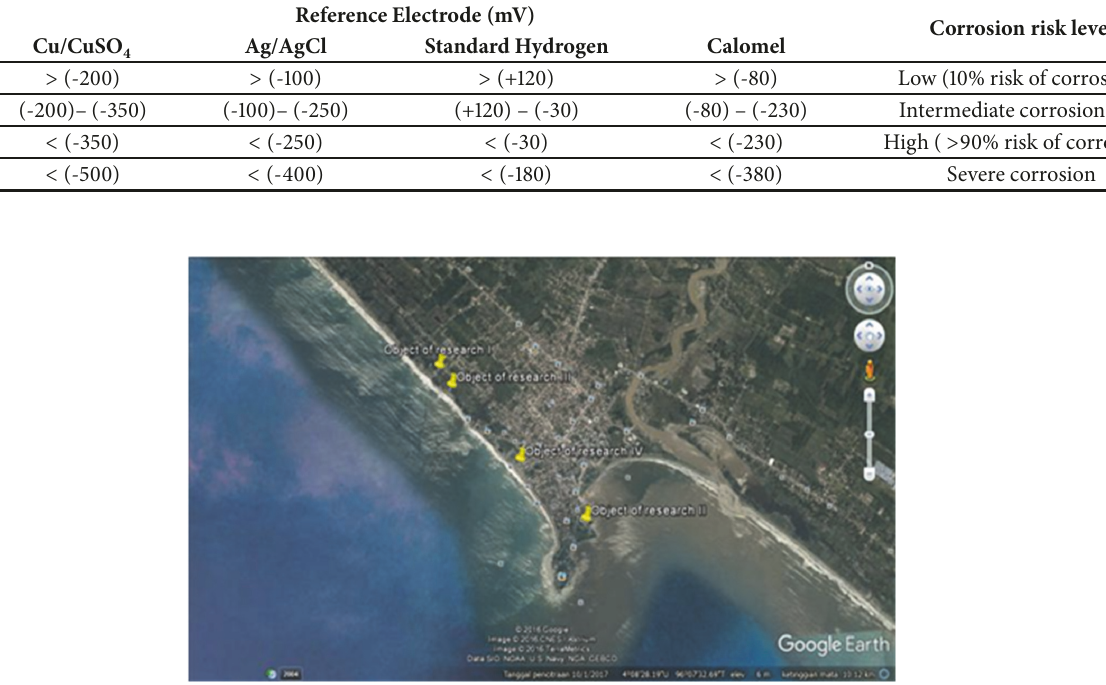
Figure 3: The locations of the reinforced concrete building for the study.